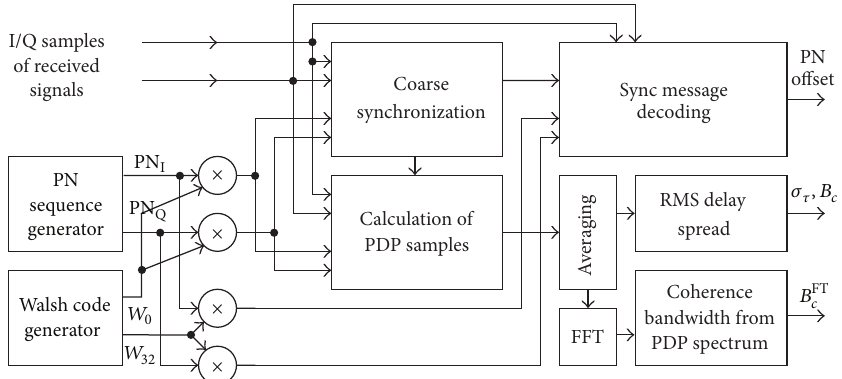
Figure 4: Block diagram of signal processing in dedicated PC software.